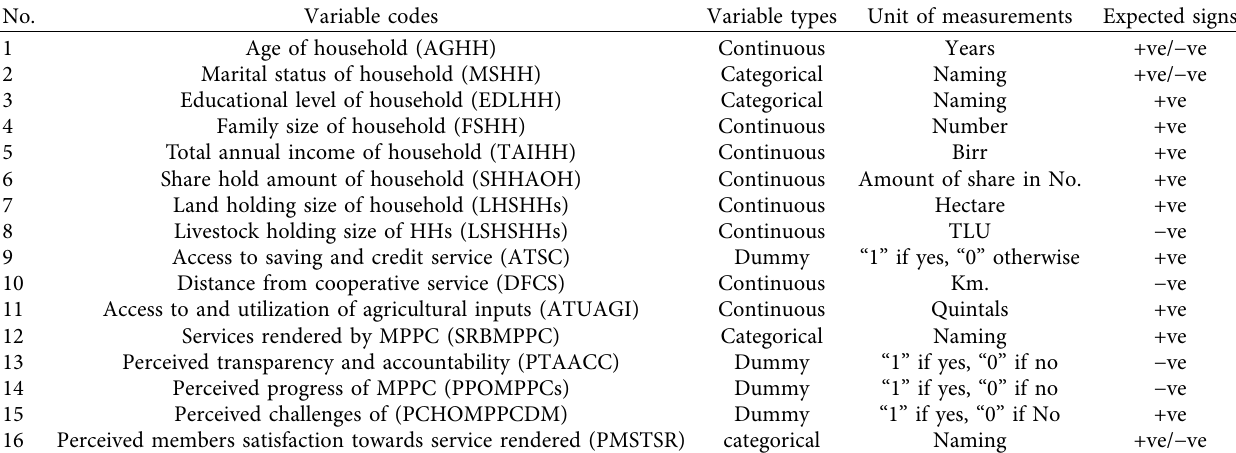
Figure 3: Sampling Table 3: Summary of hypothesized variables and their expected signs.